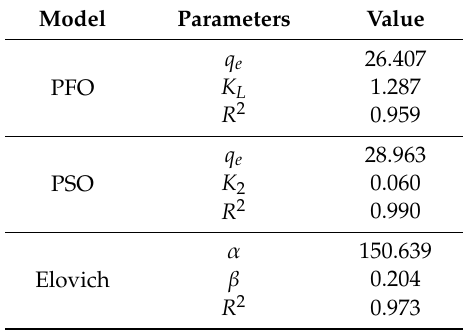
Table 2. Adsorption kinetics model parameters of SLPS for phenol.